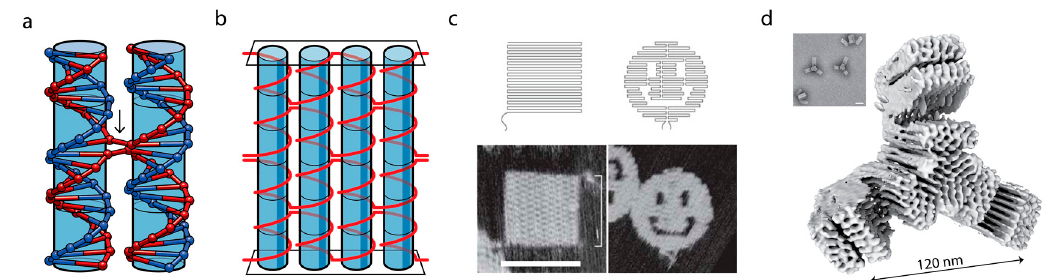
Figure 2. DNA Origami: ( a ) Basis of DNA origami is the Holliday junction, where a single strand of DNA crosses over to form a ‘crossover’ between adjacent helices. When two Holliday junctions sit along the same pair of helices this forms a double crossover. ( b ) If multiple Holliday junctions are arranged along multiple parallel helices this stitches the helices together to form a tile (adapted from [22]). ( c ) Original DNA origami tile designs and AFM from [23], showing tile and ‘three holed disc’. Scale bar = 100 nm. ( d ) CryoEM single particle reconstruction to 2.5 Å showing state of the art subunits for gigadalton assembly from [24]. Inset: representative field of view TEM micrograph, scale bar = 50 nm.